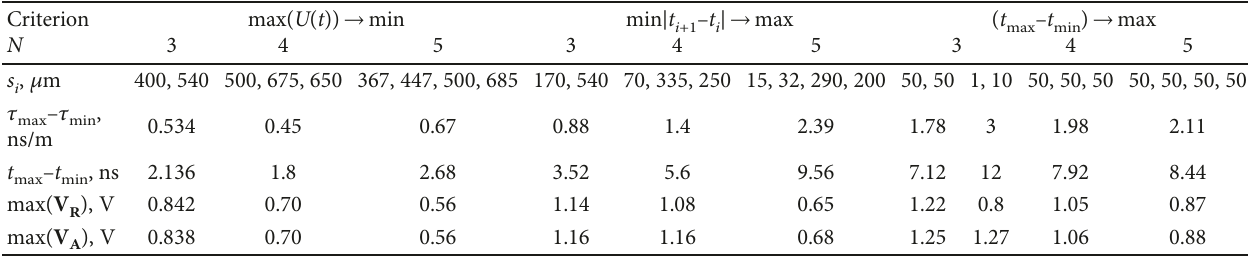
Table 4: Results of MF optimization for N = 3, 4, 5 using di ff erent criteria.